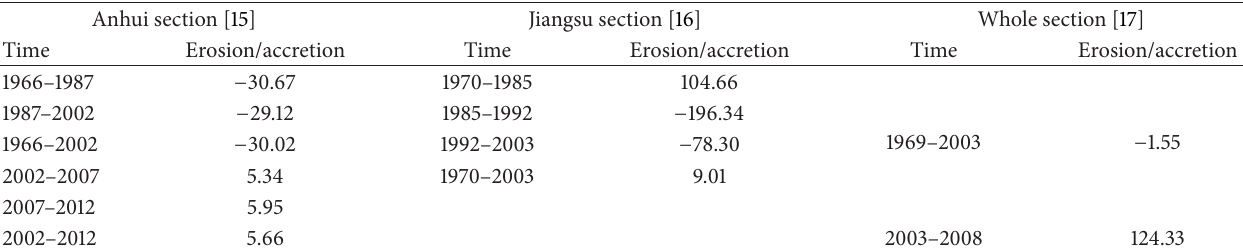
Table 2: Erosion/accretion of the river mouth reach (unit: Mt/yr) ∗